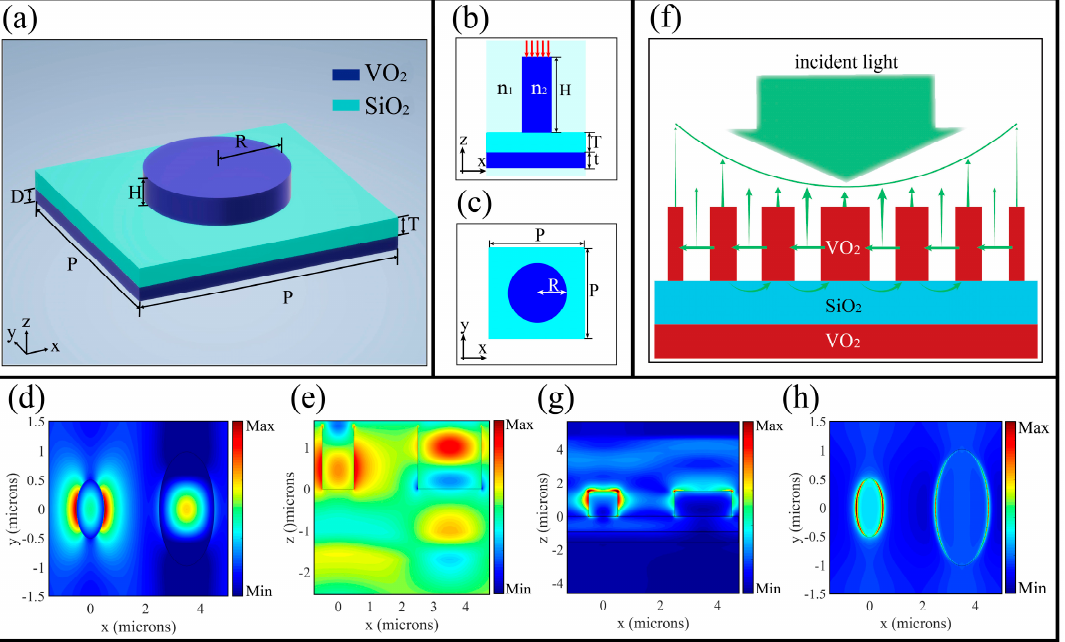
Figure 3. ( a – c ) Diagrams of the meta-atom. Along with the longitude, the materials are VO 2 ( R = 1.5 µ M, H = 1.5 µ M), SiO 2 ( T = 1 µ M), VO 2 ( D = 0.7 µ M) and the lattice constant p = 3.5 µ M; ( d , e ) are the electric near field real ( E X ) distribution in the xy -plane and xz -plane; Left and right pillars have radius of 0.5 µ M and 1 µ M, respectively; ( f ) The schematic of GSP resonance; ( g , h ) The electric near field real | E X | distribution of VO 2 -M in the xy -plane and xz -plane. The electric field in the waveguide is coupled with the surface plasma wave to control the phase gradient of the reflected light.